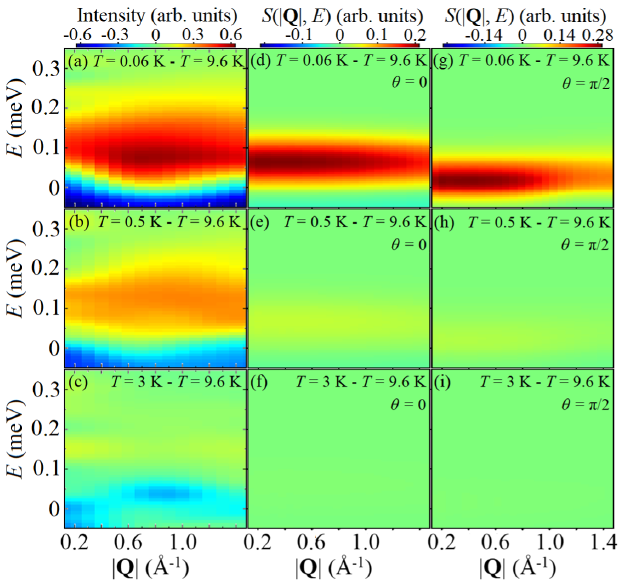
FIG. 9. The measured inelastic neutron scattering from an annealed powder sample of Ce 2 Zr 2 O 7 is shown in panels (a) – (c) for temperature-subtracted data relative to T ¼ 9 . 6 K. The corresponding powder-averaged neutron scattering structure factors [ S ðj Q j ; E; T Þ ] calculated from semiclassical molecular dynamics calculations based on Monte Carlo simulations using near-neighbor exchange parameters from the A regime, ð J ˜ x ; J ˜ y ; J ˜ z Þ ¼ ð 0 . 064 ; 0 . 063 ; 0 . 011 Þ meV, are shown in panels (d) – (i). The temperatures of the measured and calculated datasets ( T ¼ 0 . 06 , 0.5, and 3 K) and the θ values used in the calculations ( θ ¼ 0 and π = 2 ) are as indicated in the individual